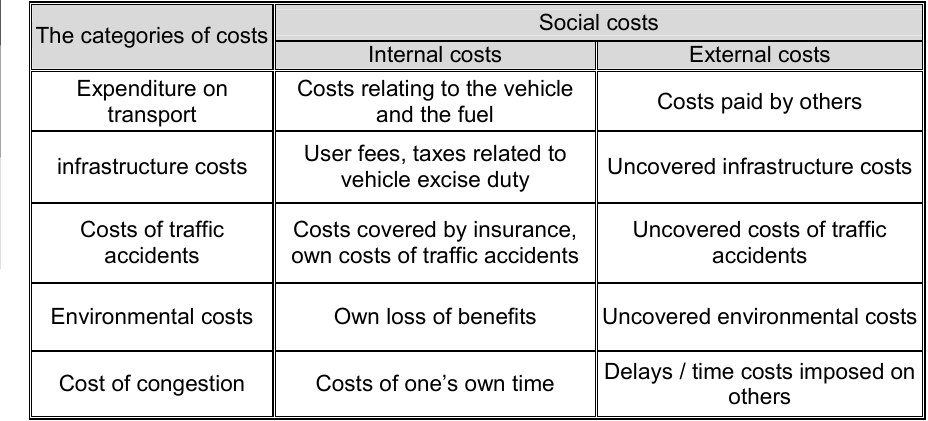
Table 1 – Classification of costs in transport Таблица 1 – Классификация затрат по